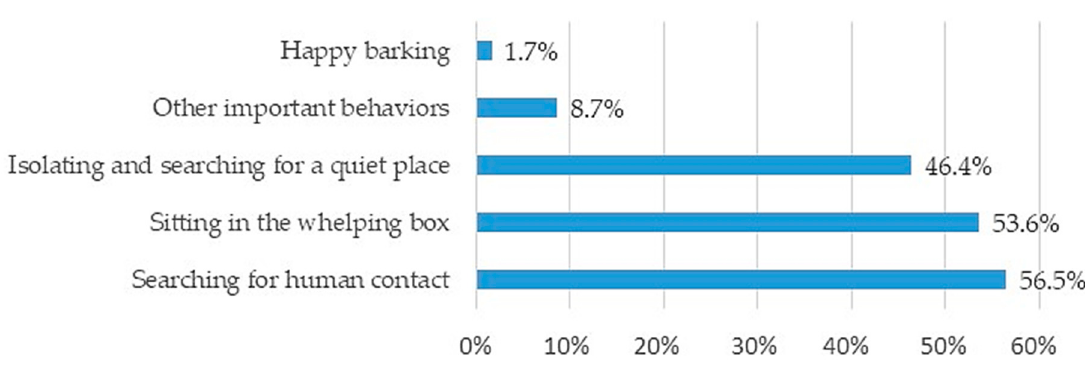
Figure 9. Signs of a non-stressed bitch during the whelping time (multiple answers allowed).